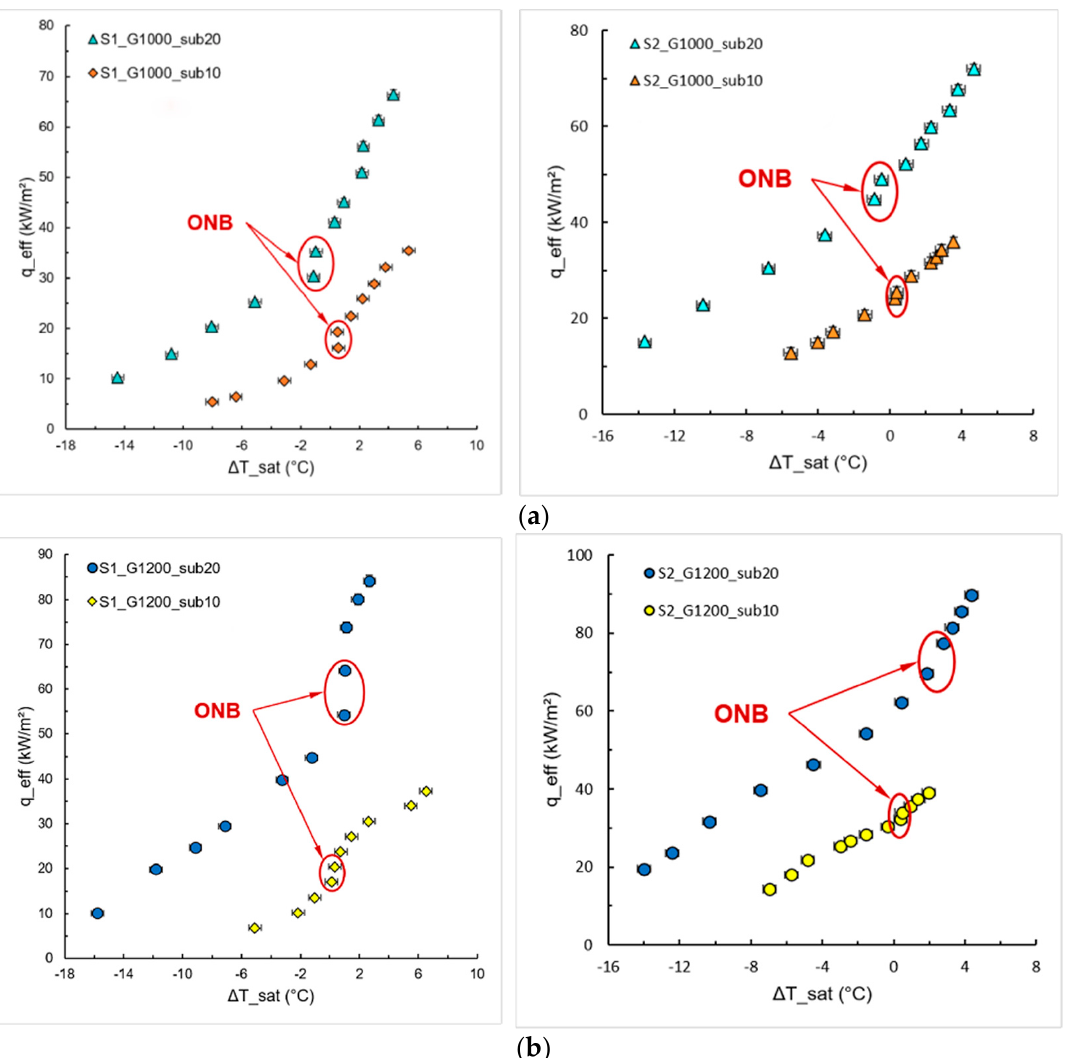
Figure 6. E ff ect of inlet subcooling temperature on fl ow boiling heat transfer of HFE-7100 for S1 Figure 6. Effect of inlet subcooling temperature on flow boiling heat transfer of HFE-7100 for S1 and and S2. ( a ) G = 1000 kg/m 2 s; ( b ) G = 1200 kg/m 2 s. S2. ( a ) G = 1000 kg/m 2 s; ( b ) G = 1200 kg/m 2